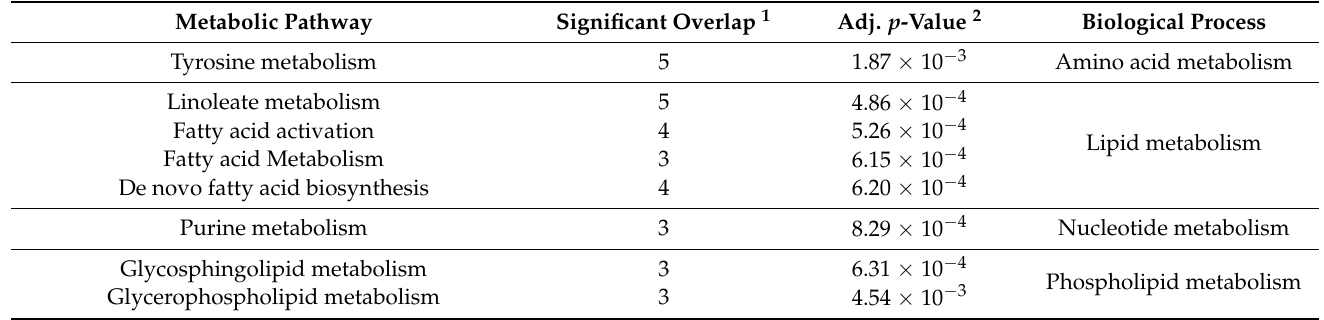
Table 1. The enriched metabolic pathways associated with MAFLD (metabolomics).